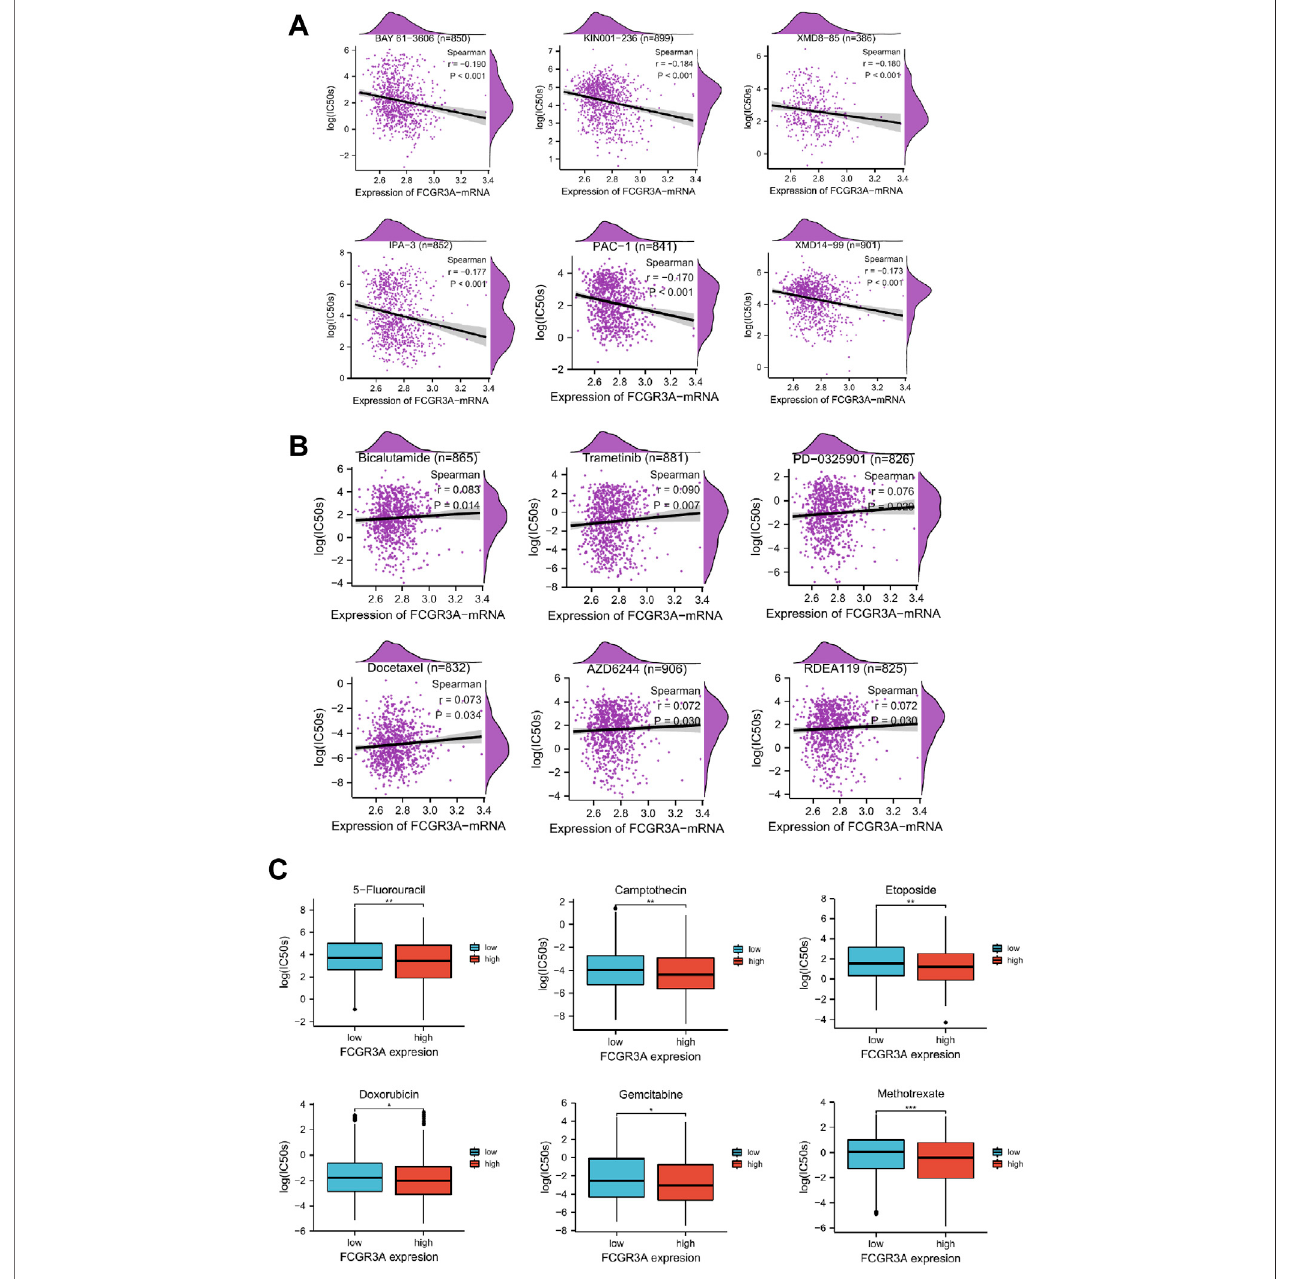
FIGURE 10 | Relationship between FCGR3A expression and drug sensitivity. (A) The top six negatively correlated. (B) The only six positively correlated. (C) The difference ofdrugsensitivityofsixcommonly used anticancerdrugs (5- fl uorouracil,Camptothecin,Etoposide,Doxorubicin, Gemcitabine,and Methotrexate)inhigh and low FCGR3A expression groups was shown in the forms of boxplot charts. * p < 0.05; ** p < 0.01; *** p <